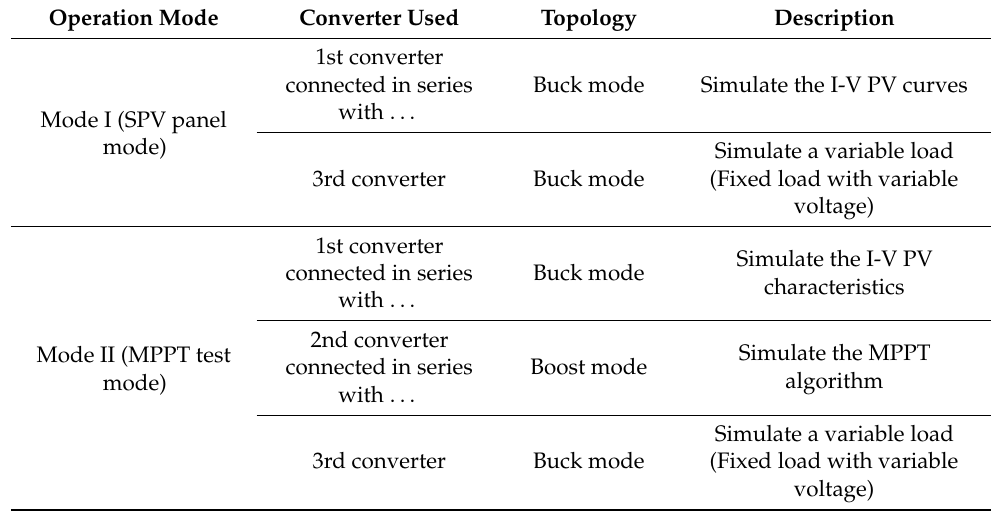
Table 1. Summary of the different operation modes and converter’s